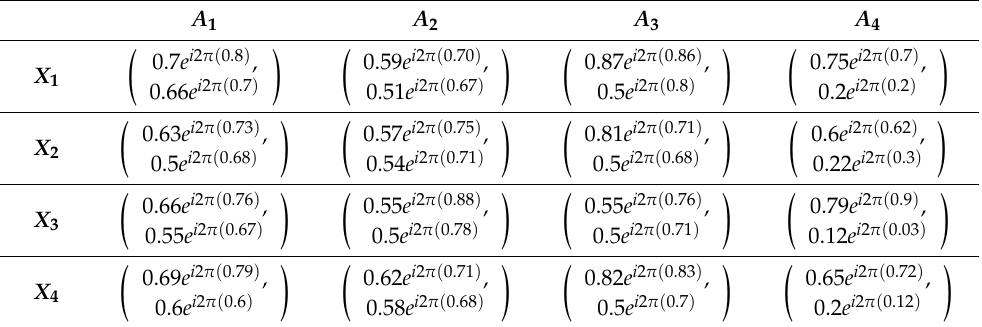
Table 3. Decision matrix for Example